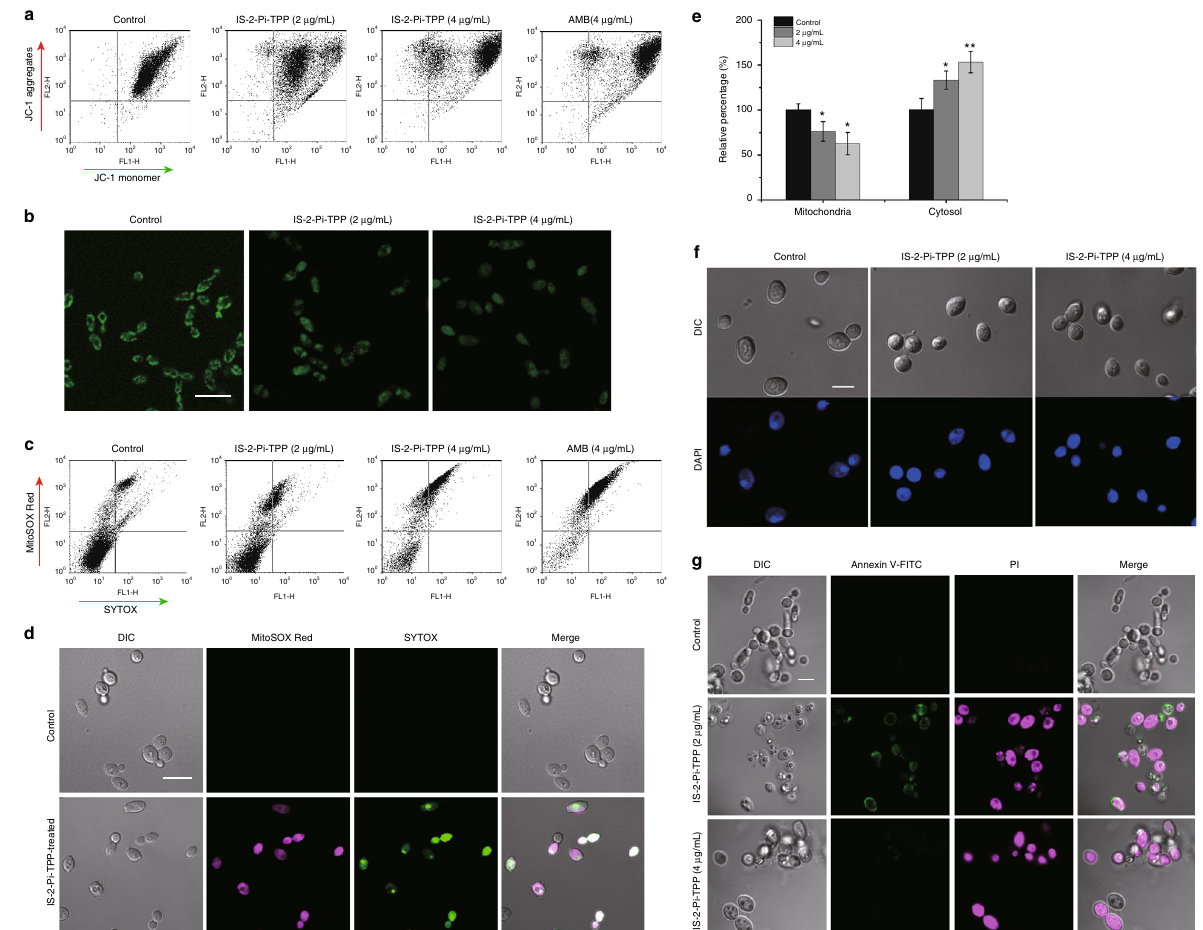
Fig. 3 The disruptive effect of IS-2-Pi-TPP on mitochondria. a The effect of IS-2-Pi-TPP on MMP was monitored by JC-1 staining. JC-1 aggregates accumulate in mitochondrial matrices with high MMP and emit orange-red fl uorescence. Upon depolarization of the mitochondrial membrane, JC-1 aggregates are dissipated into the cytoplasm as monomers that emit green fl uorescence. b The effect of IS-2-Pi-TPP on mitochondrial morphology, as indicated by the Tom70-GFP distribution. Scale bar, 10 μ m. c and d MitoSOX Red and SYTOX were used to indicate the redox state of the mitochondria and the survival state of C. albicans , respectively. Superoxide production in the mitochondria and the survival state induced by IS-2-Pi-TPP were detected by fl ow cytometry ( c ) or observed by confocal microscopy ( d ). Scale bar, 10 μ m. e The relative contents of Cyt c in the mitochondria and cytosol in cells treated with the indicated concentrations of IS-2-Pi-TPP. Data are shown as means ± s.e.m. from three independent experiments. * P < 0.05, ** P < 0.01 by Student ’ s t -test. f Nuclear damage of C. albicans cells in response to IS-2-Pi-TPP treatment. Scale bar, 5 μ m. g Apoptosis and necrosis of C. albicans induced by IS-2-Pi-TPP. Cells were stained with Annexin V-FITC or PI to detect characteristics of apoptosis or necrosis under treatment with IS-2-Pi-TPP. The stained cells were observed by CLSM. Scale bar, 5 μ m. In a and c , a total of 10,000 events were collected for data analysis without using speci fi c gating strategies (Fig. 3g). These results suggest that IS-2-Pi-TPP exerts fungicidal activity by inducing both cell apoptosis and necrosis.